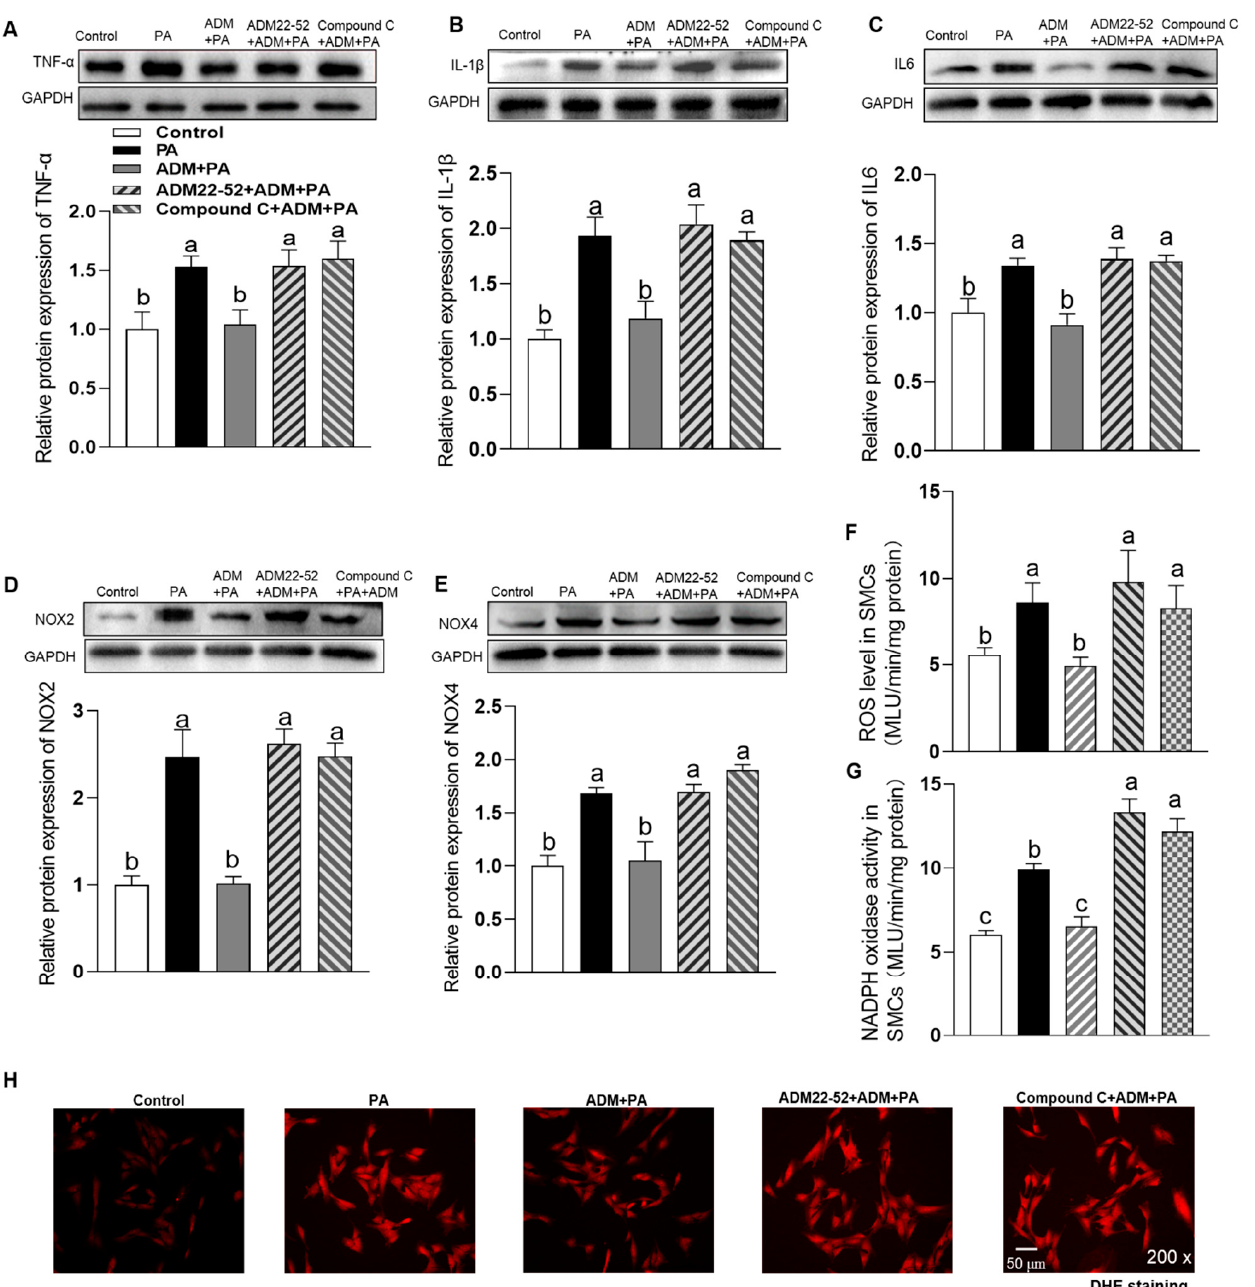
Figure 4. The effects of ADM receptor antagonist ADM22-52 (1 µ M) or AMPK activation inhibitor compound C (10 µ M) on ADM’s response to inflammation and oxidative stress induced by PA (200 µ M) in A7r5 cells. The protein expression levels of proinflammatory cytokines TNF- α ( A ), IL-1 β ( B ) and IL6 ( C ) were measured to reflect inflammation state and the NOX2 and NOX4 protein expression levels ( D , E ), ROS level ( F ), NADPH oxidase activity ( G ) and DHE fluorescence staining (intracellular ROS evaluation, H ) were detected to reflect oxidative stress state. ADM (10 nM) was administrated in A7r5 cells for 30 min, then cells were exposed to PA for further 24 h. ADM22-52 or compound C was added 30 min before ADM application, respectively. Each value indicates mean ± SEM. n = 3 to 6. Values with the same superscript letter are not significantly different and the different letters indicate significant differences between the groups ( p < 0.05, one-way ANOVA followed by Bonferroni post hoc analysis, ( A – G )).